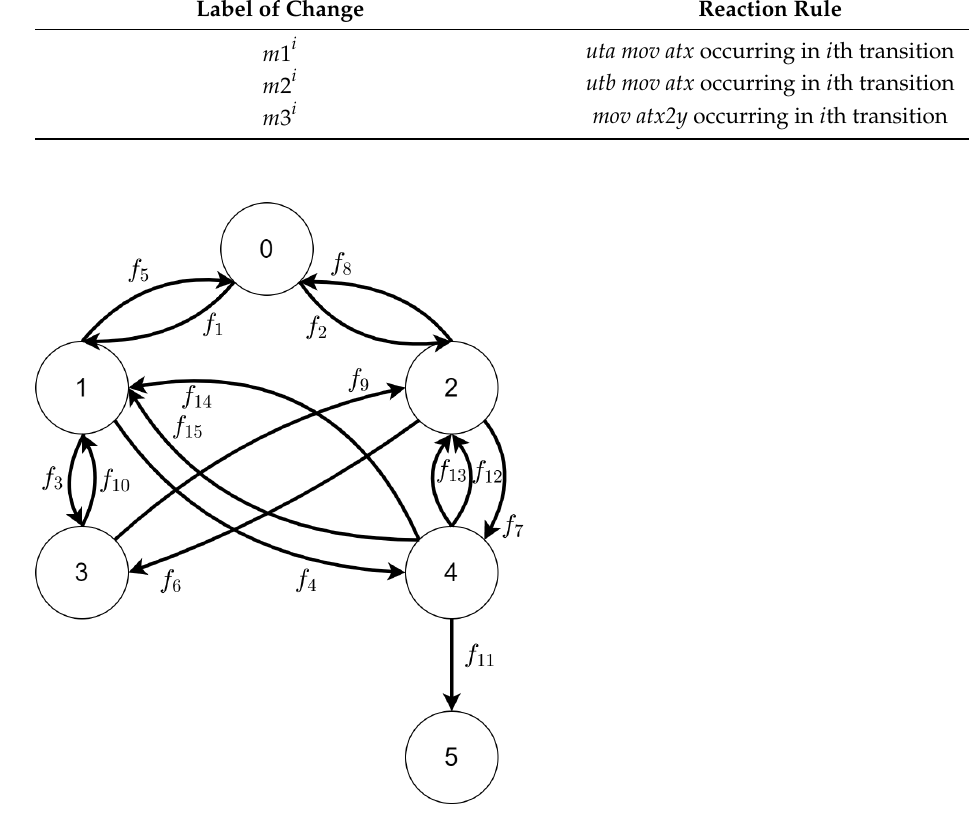
Figure 7. The state space for scenario 1 based on Tracking Transition System defined in Appendix